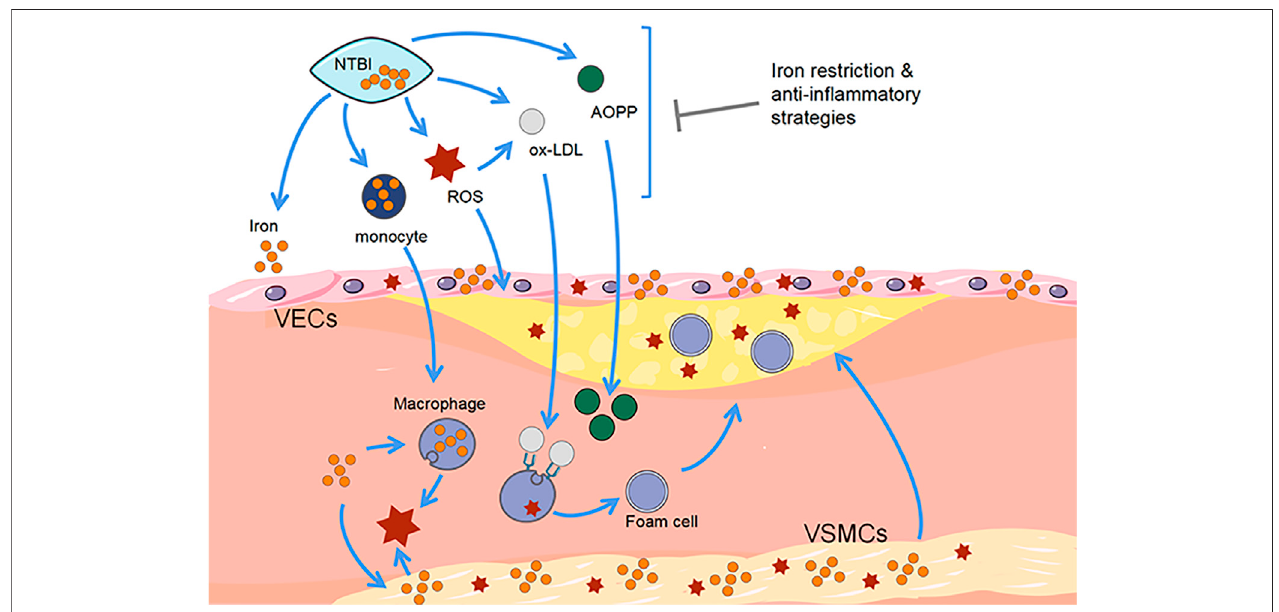
FIGURE 2 | Correlation between ferroptosis and progression of atherosclerotic plaques. Free iron promotes the development of AS and increases the risk of cardiovascular disease. The detrimental effects of iron accumulation resulting from the presence of macrophages, endothelial cells, and vascular smooth muscle cells exacerbatetheformationofatheroscleroticplaques.Diseaseprogressioncanbepreventedbyiron-consumingstrategies.VSMCs,vascularsmoothmusclecells.VECs, vascular endothelial cells. NTBI, non-transferrin-bound iron. ROS, reactive oxygen species. Ox-LDL, oxidized low density lipoprotein. AOPP, advanced oxidation protein products.